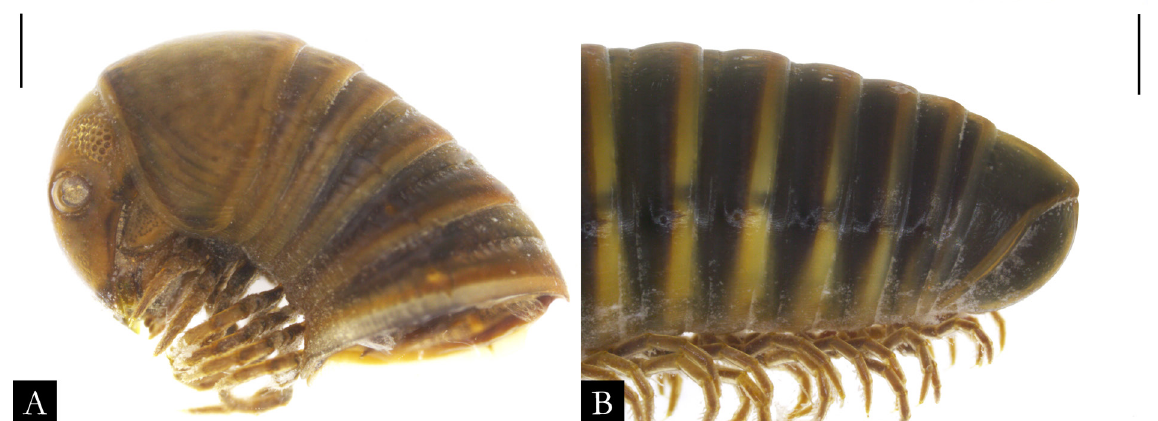
Fig. 147. Pseudonannolene aurea sp. nov., paratype, ♂ (IBSP 5854), in lateral view. A . Anterior region. B . Posterior region. Scale bars = 1